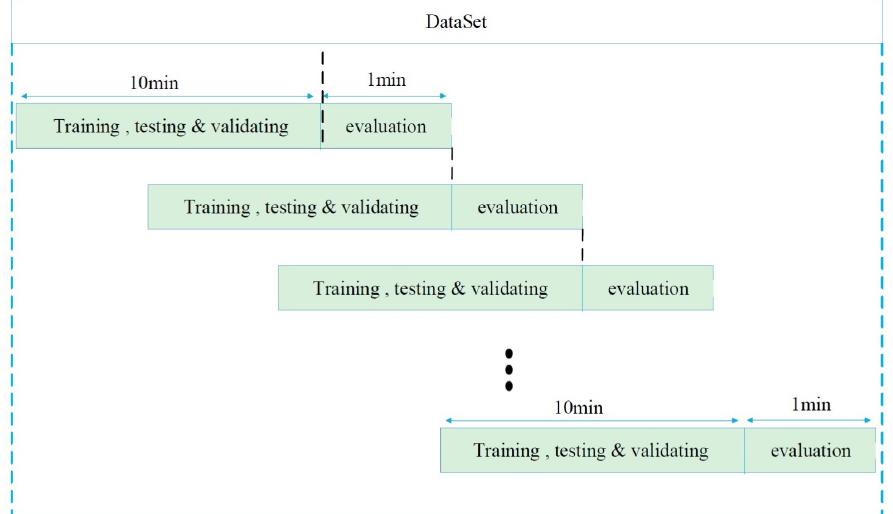
Figure 12. The time slice division of